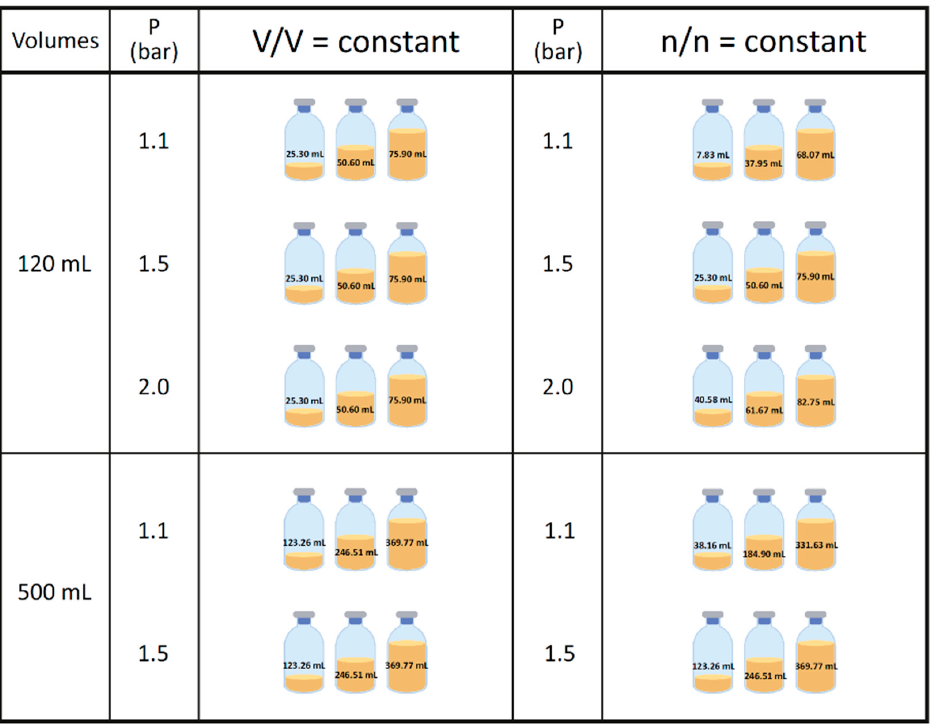
Figure 2. Schematic overview of the experimental set-up in 117 mL serum bottles. Pressure is given in bar relative to atmospheric pressure. Experiments in the 117 mL bottles were performed in quadruplicates (n = 4), and samples obtained after two different incubation intervals and repeated twice (N = 2). The final media and inoculum volumes for each experiment can be found in Table S1. Quadruplicates of each volume and pressure variant were applied with an additional zero control to each experimental set for the 117 mL experiments. Due to logistic reasons, the experiments performed with the 570 mL flasks were performed in triplicates without zero controls. Inoculation was done in an anaerobic chamber (Coy Laboratory Products, Grass Lake, MI, USA) from a cultivated inoculum in defined media (Section 2.2). The re- sidual CH 4 was interchanged with a H 2 /CO 2 (4:1 ratio, 99.995% purity (Air Liquide, Schwechat, Austria)) gas mixture twice per day with different pressure values adjusted to 1.1, 1.5, or 2 bar. The pressure is given as bar relative to atmospheric pressure throughout this study. The experimental conditions and settings are detailed in Figure 2 (and Table S1), which shows an overview of the gas phase pressure values and the volumetric (V/V) and molar (n/n) constant alternatives. For the experiments termed as V/V = const, the ini- tial liquid volume was constant with varying pressure (1.1, 1.5, 2.0 bar) within the 117 mL (25.3, 50.6, 75.9 mL) and 570 mL (123.3, 246.5, and 369.8 mL) settings, respectively. Note that the volumetric ratios between the liquid and gaseous phase in the 117 mL and 570 mL bottles are the same for the V/V = const. setting. In contrast, for the n/n = const. settings, the aim was to have the same initial number of moles of the gas phase in three different pressure settings (treated as ideal gas at room temperature, 22 °C). These three settings were defined by the number of moles at 1.5 bar in the 117 mL bottles, at 25.3, 50.6, and 75.9 mL initial volumes. The different starting volumes of the experiments performed at different pressure values were then calculated according to the ideal gas law. For better readability, we refer in further text to the small, medium, and large volumes in the 117 mL or 570 mL bottles at the conditions V/V = const. or n/n = const. The experiments in the 117 mL setting were conducted twice at two different incubation intervals and total times.